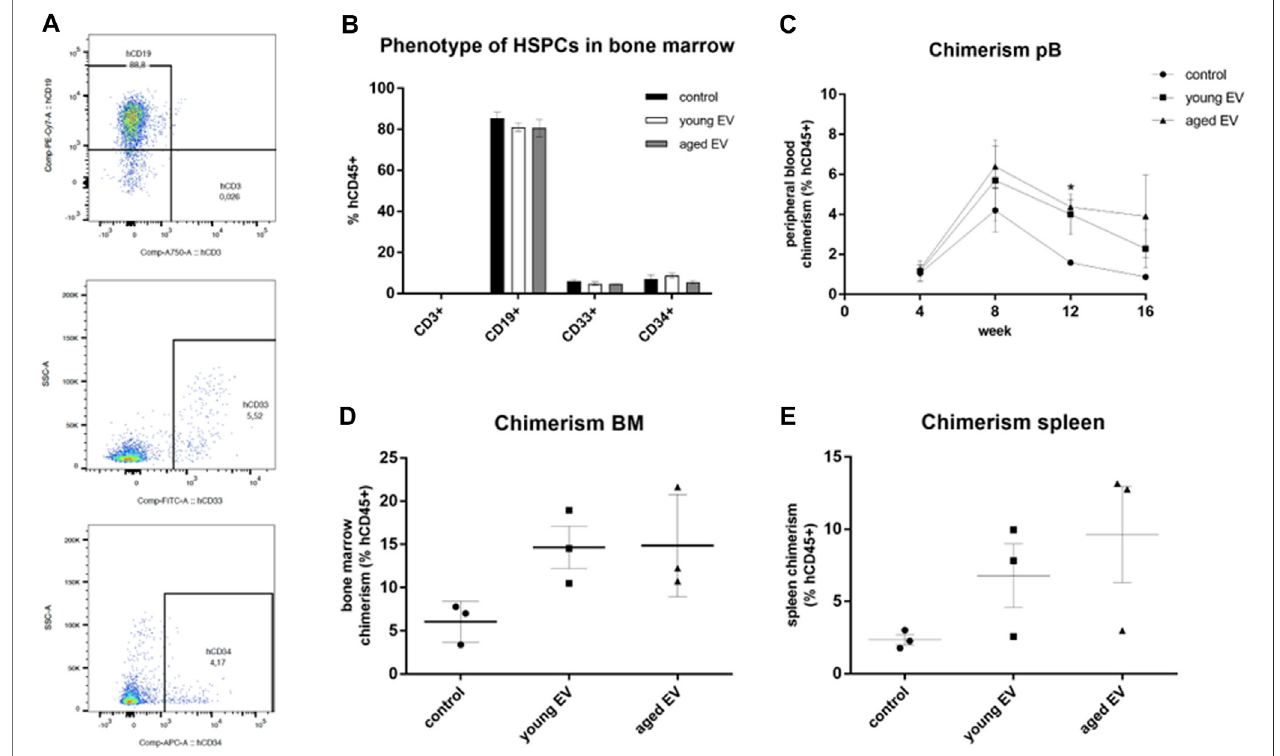
FIGURE 6 | Effects of MSC-EV treatment on HSPC engraftment in vivo . HSPCs were treated for 72 h with young or aged MSC-EVs or buffer as a control, respectively, and injected into NSG mice (n = 3 per group). Mice were kept for 16 weeks. Phenotype and chimerism was analyzed by fl ow cytometry after gating on human CD45 + cells. (A) Representative dot plots for the detection of human cells expressing CD3, CD19, CD33 or CD34, respectively. (B) Phenotype of human CD45 + cells in the BM. Lymphoid cells were detected by CD3 (T cells) and CD19 (B cells), myeloid cells by CD33 expression. (C) The chimerism de fi ned as percentage of human CD45 + cells amongst all CD45 + cells was analyzed every 4 weeks in the peripheral blood. (D,E) The chimerism in the BM and in the spleen was analyzed 16 weeks after transplantation. The bars represent the mean ± SEM from three different mice in each group, * p < 0.05.